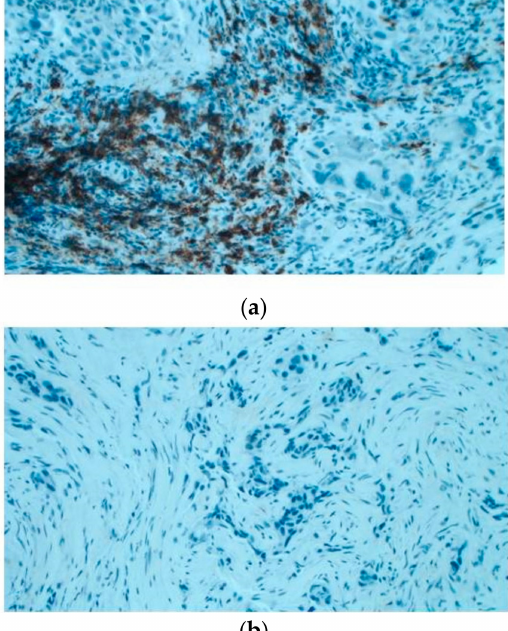
Figure 5. Immunoistochemical evaluation of B cell infiltration in ( a ) KRAS WT (60% of infiltration) and ( b ) mutated cases (0% infiltration), respectively (magnification: 20 × ) Moreover, cases in LUAD-TCGA with low B cell infiltration have a significantly worse overall survival than those with higher levels (Figure 6a). Interestingly, in the real-life cohort we observed the same results stratifying for presence / absence of KRAS mutation, with mutated patients having a poor outcome (Figure 6b). Moreover, mutated patients in cluster 2 have a worse overall survival than cluster 1 KRAS WT cases (Figure